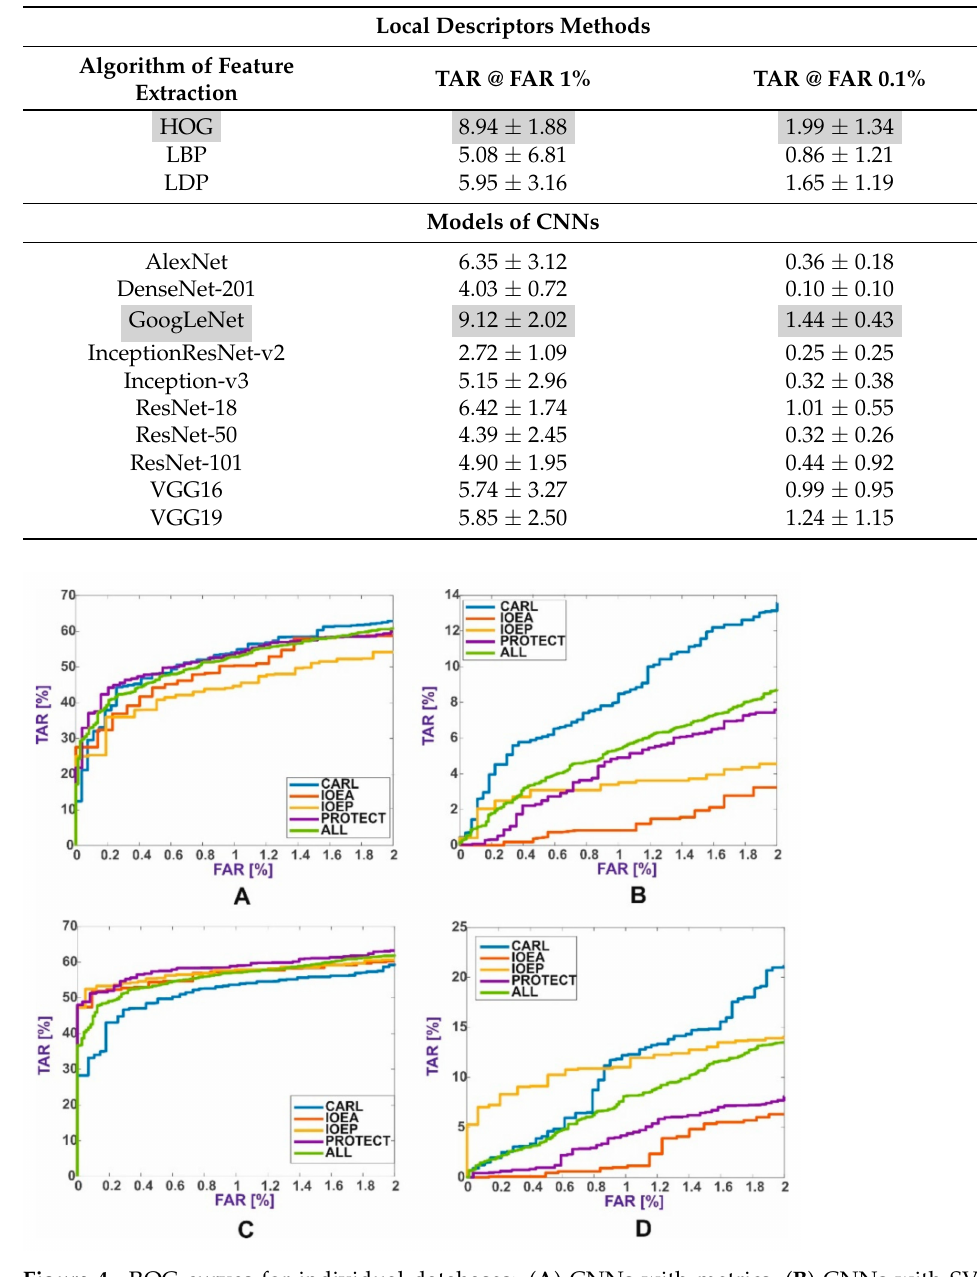
Figure 4. ROC curves for individual databases: ( A ) CNNs with metrics, ( B ) CNNs with SVM, ( C ) local descriptor methods with metrics, and ( D ) local descriptor methods with